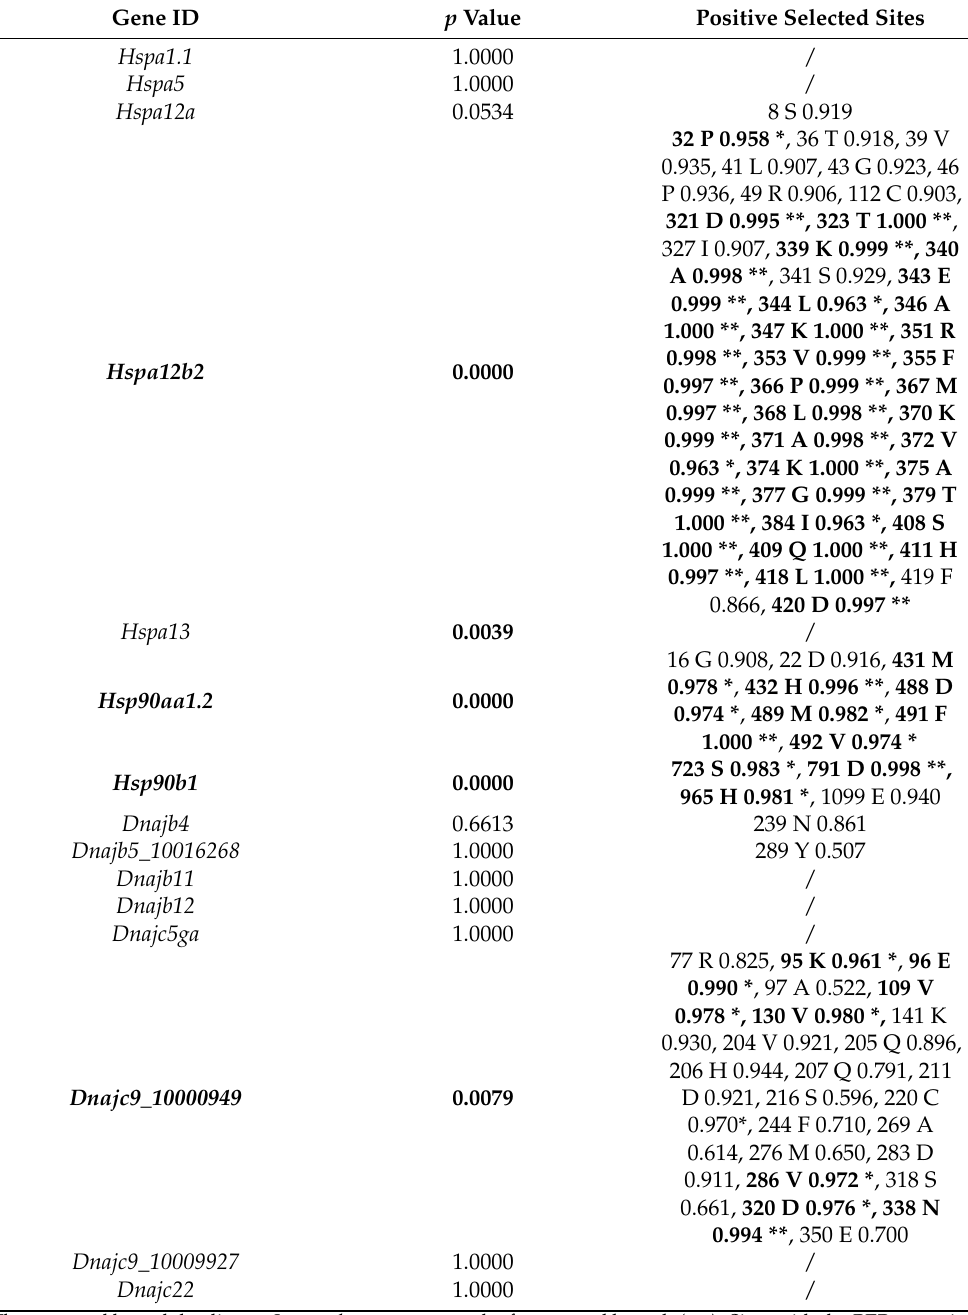
Table 1. Branch-site model tests for the 15 coordinated regulated LmHsp40-70-90 co-chaperons (Figure 5C) between L. maculatus and other teleost species. p